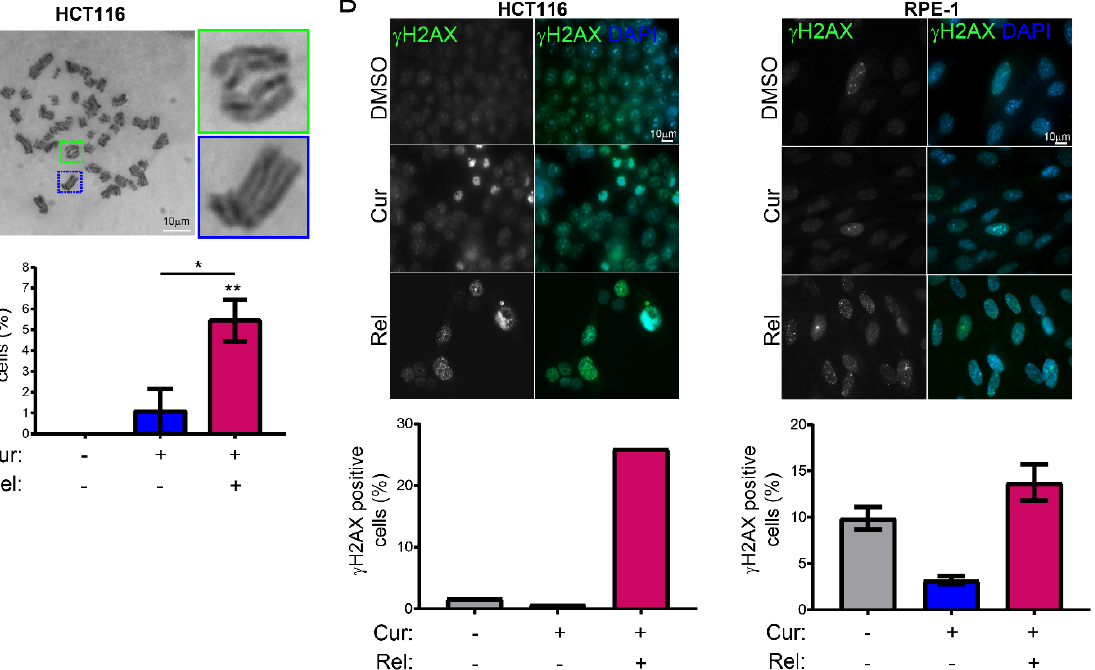
Figure 2. Curcumin treatment induces mitotic slippage and DNA damage: ( A ) Representative Giemsa-staining images of metaphase spreads of HCT116 cells with the indicated treatment. Enlargements of few chromosomes are attached on the right. Scale bar = 10 µm. Graph showing the percentage of endoreduplicated cells for each indicated sample. n = 3. Un-paired t -test: ** p < 0.01, * p < 0.05; ( B ) representative immunofluorescence images showing gH2AX-positive HCT116 and RPE-1 cells in the indicated cell treatment. Scale bar = 10 µm. Graph summarizing the results of one experiment for HCT116 cells and two independent experiments for RPE-1 cells; ( C ) immunoblots of cell extracts with antibodies against p53 and γ H2AX. HCT116 cells treated with hydroxyurea (HU) are used as a positive control for DNA damage. Antibody against actin is used as a loading control; ( D ) Representative metaphase spread image showing chromosome break in HCT116 cells with the indicated cell treatment. Arrows indicate chromosome. On the right side, there is an enlargement of a broken chromosome. Scale bar = 10 µm. Graph summarizing the results of two independent experiments. 3.3. Curcumin-Induced Senescence Is Associated with p21 waf1/cip1 Activation and Global Reduction in Heterochromatin Markers To further characterize curcumin-induced senescence, we evaluated the presence of senescence-associated markers. Then, we investigated the increase in p21 waf1/cip1 , which is largely considered responsible for the permanent cell-cycle arrest of senescent cells, together with p16 ink4a [15]. The results show that both the transcript and the p21 waf1/cip1 protein were increased in HCT116 Cur and Rel cells with respect to control cells (Figure 3A,B). An increase in p21 waf1/cip1 was also observed in MCF-7 cells under the same treatment (Supplementary Figure S1B,C). Additionally, p16 Ink4a was not increased in HCT116 cells (data not shown), suggesting that the curcumin-induced senescence was